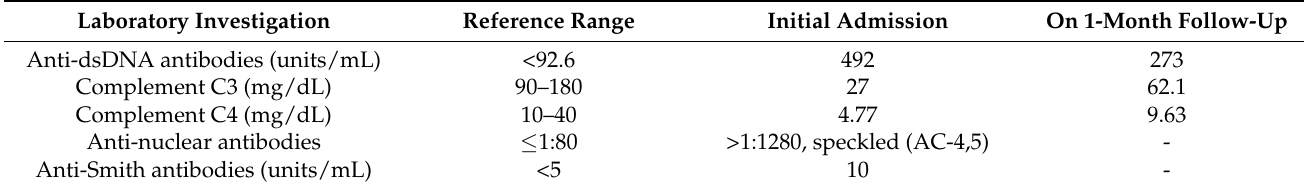
Table 1. Summary of key laboratory investigation results during initial admission and on 1-month